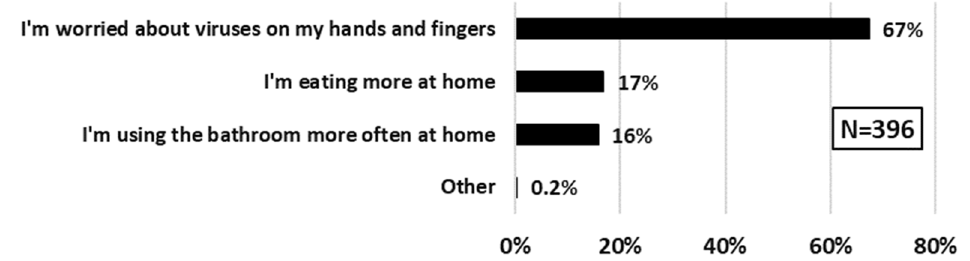
Figure 7. Reasons for increased frequency of hand washing (multiple responses).